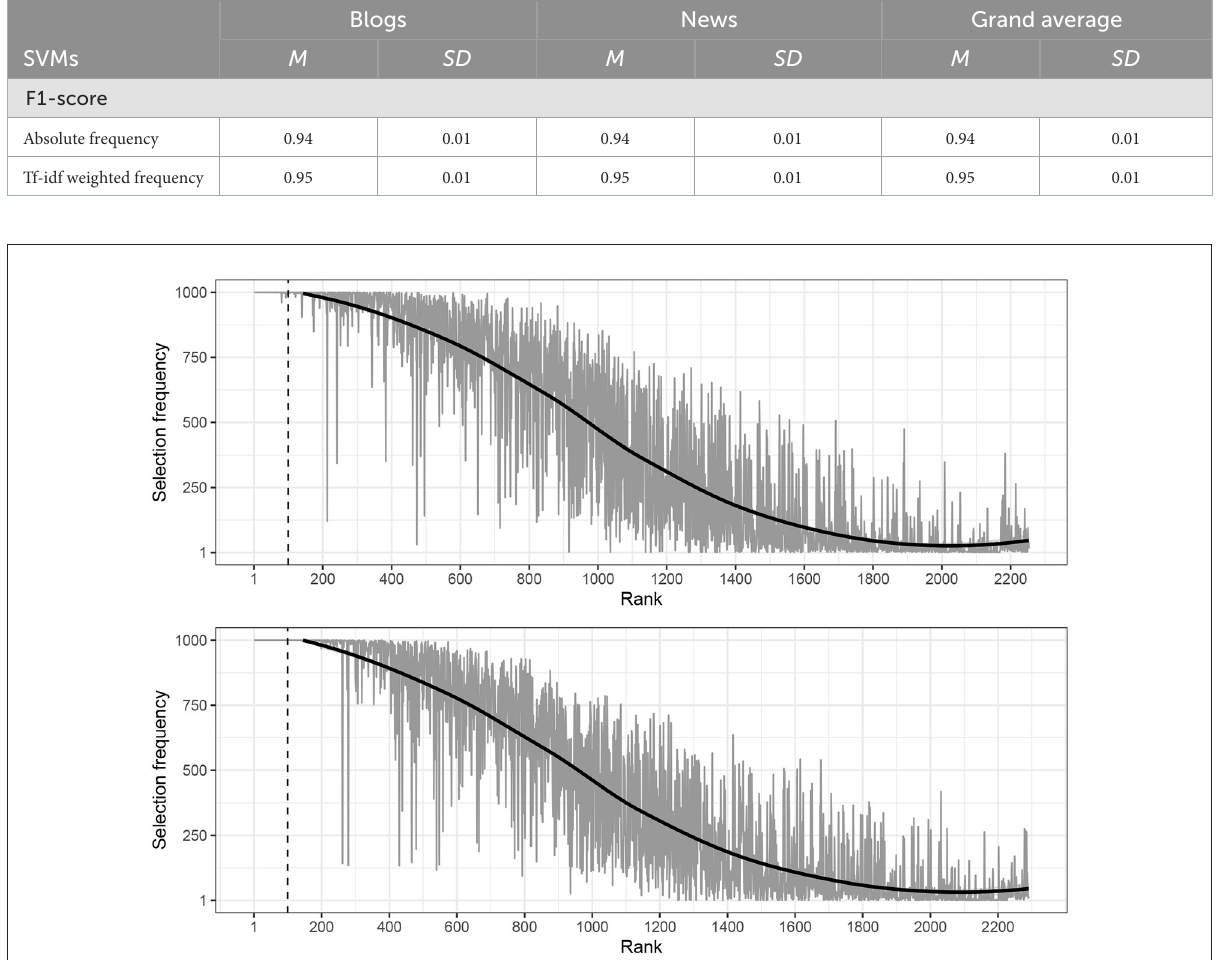
FIGURE2 Visualization of the relationship between the selection frequency and rank of the estimated weights presented separately for news (top) and blogs (bottom) estimated with SVMs (tf-idf). The dashed vertical line indicates the delimiter of the top 100 keyword. The solid black trend line was estimated with